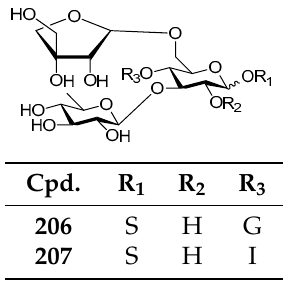
Cpd. Figure 31. Structures of compounds 2 02 – 205 . Figure 31. Structures of compounds 2 02 – 205 . Figure 31. Structures of compounds 2 02 – 205 . Figure 31. Structures of compounds 2 02 – 205 . Figure 31. Structures of compounds 2 02 – 205 .